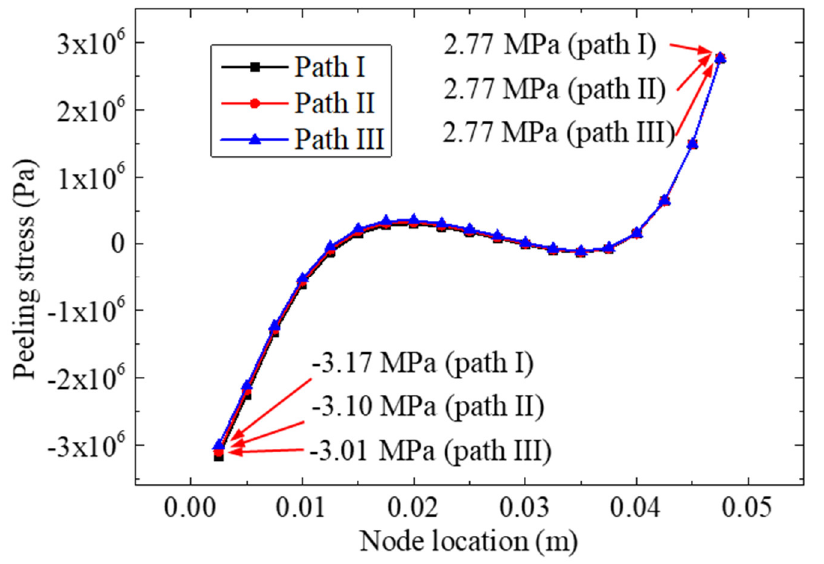
Figure 6. Peeling stresses distribution curve for the three paths.